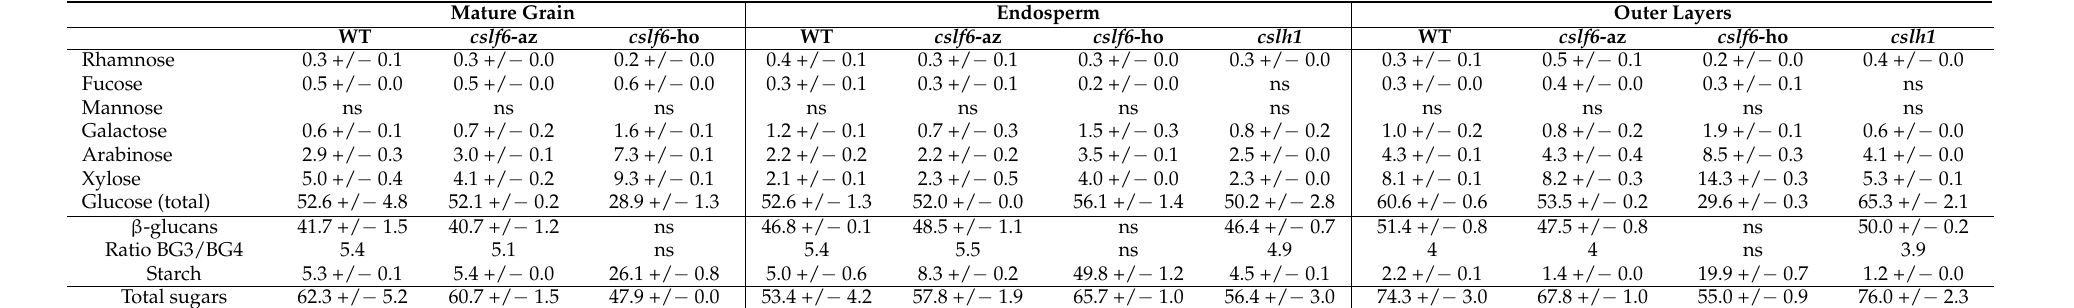
Table 2. Sugar composition of alcohol insoluble residues (AIR) of whole grains compared to separated endosperm and outer layers of cslh1 and cslf6 mutants and controls (WT and azygous cslf6 ) determined by gas chromatography analysis. Determination of starch and MLG content was carried out by HPAEC analysis.